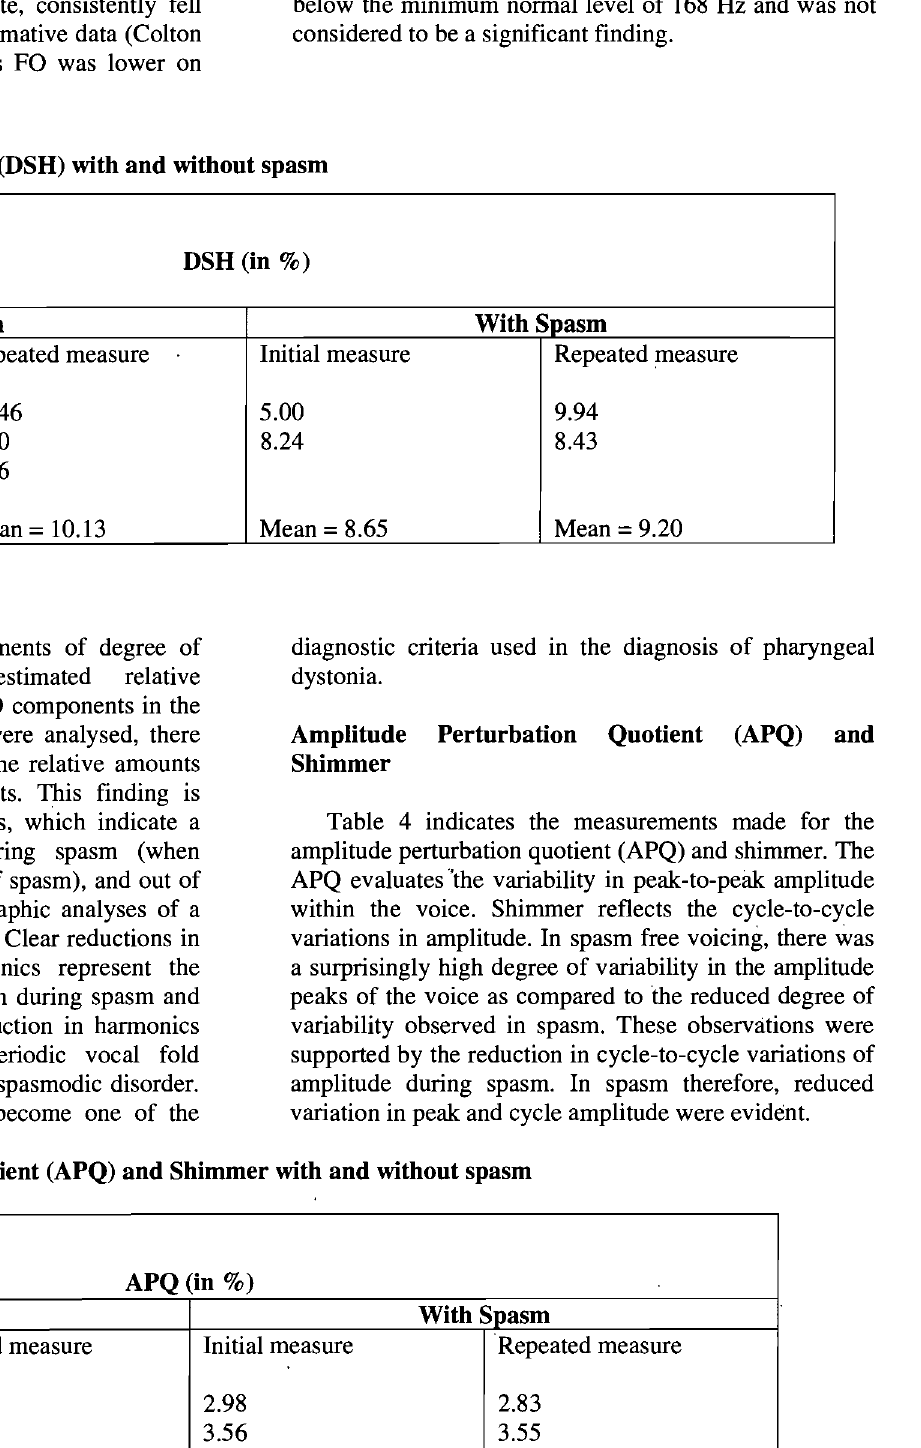
Table 3: Degree of Sub harmonics (DSH) with and without spasm